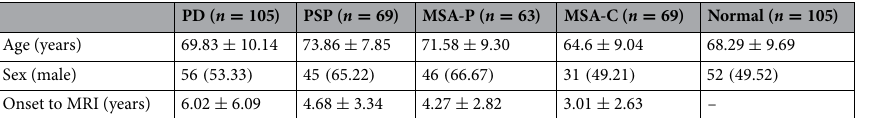
Table 4. Demographic and clinical characteristics of patients enrolled in this study. Data are shown as mean ± standard deviation or n (%). PD Parkinson’s disease, PSP progressive supranuclear palsy, MSA-P multiple systemic atrophy-Parkinsonian type, MSA-C multiple systemic atrophy-cerebellar